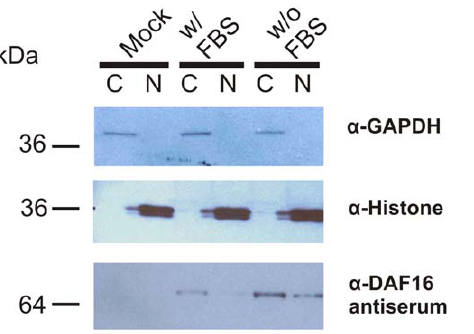
Figure 3. Gene transcription from DAF-16 binding elements driven by Ac -DAF-16 is negative regulated by IIS. A ) Luciferase activity of insulin sensitive HepG2 expressing full-length Ac -DAF-16 treated with serum ( + FBS), without serum ( 2 FBS) and insulin ( + Ins). B )